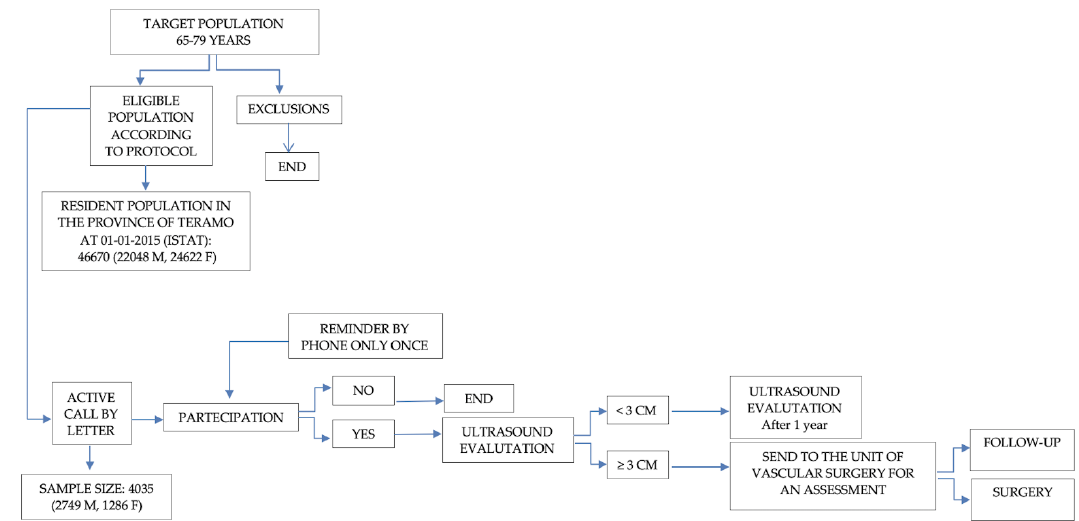
Figure 1. Study Figure 1. Study- flowchart.